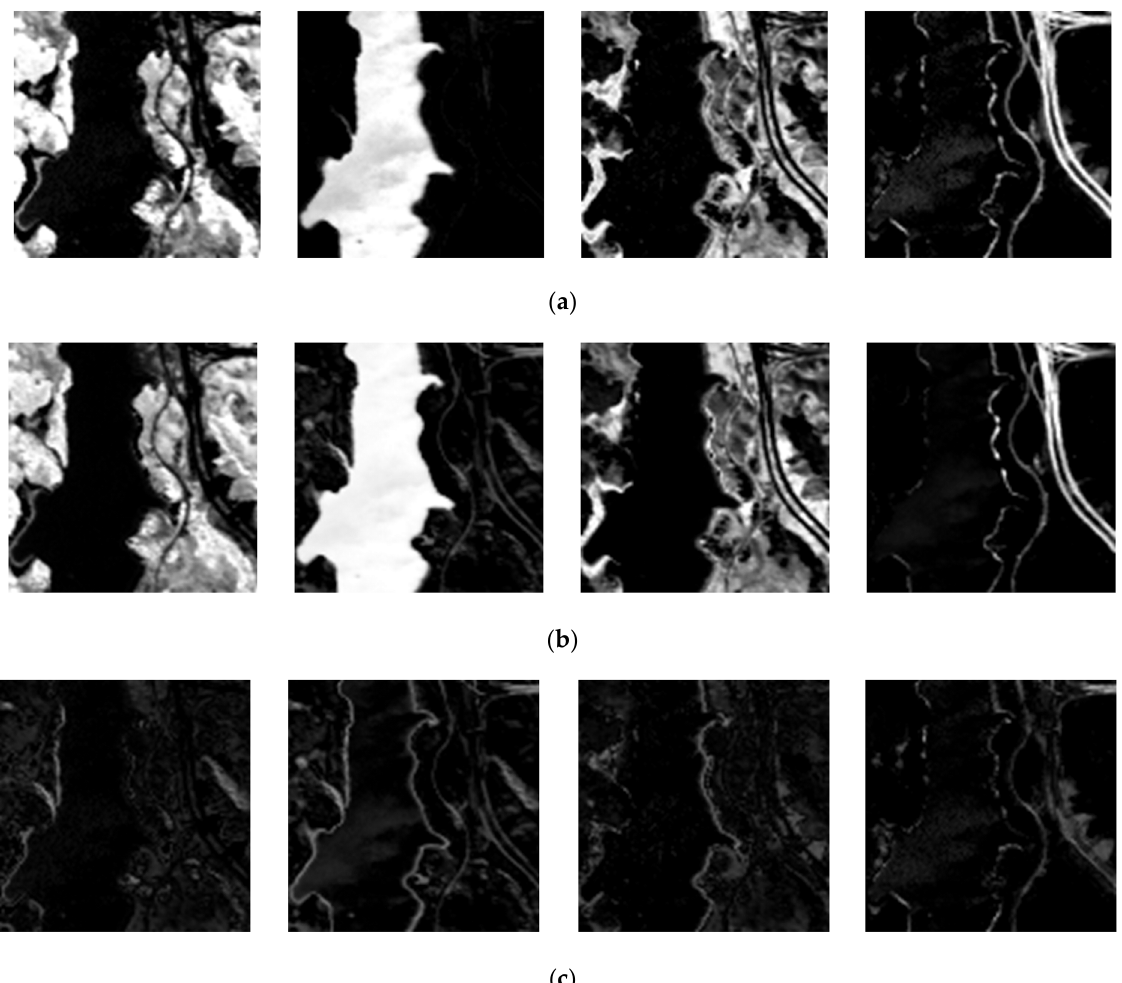
Figure 15. From left to right are ( a ) the ground-truth abundance maps; ( b ) the estimated abundance maps; ( c ) absolute error maps of tree, water, soil and road in Jasper Ridge.